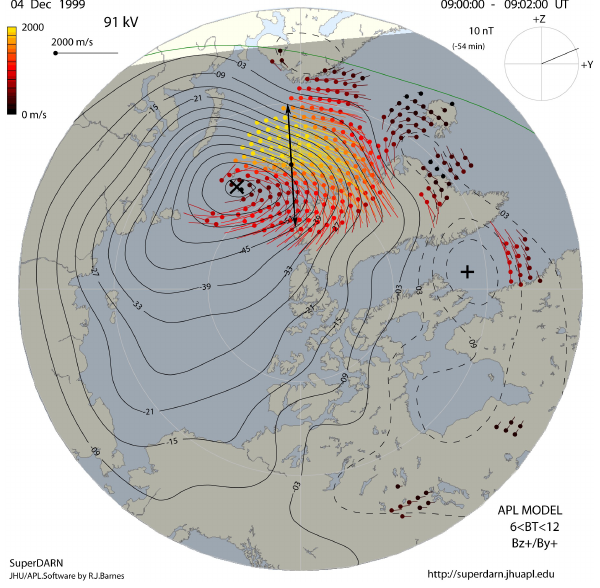
Fig. 14. SuperDARN convection data for 09:20–09:22UT. Same format as in Fig. 8. The track of spacecraft DMSP F13 during the interval 09:09–09:19UT has been overlayed. Precipitation regimes along the track are indicated. Latitudinally separate auroral forms have been marked along the Ny ˚Alesund MSP scanning meridian ( ∼